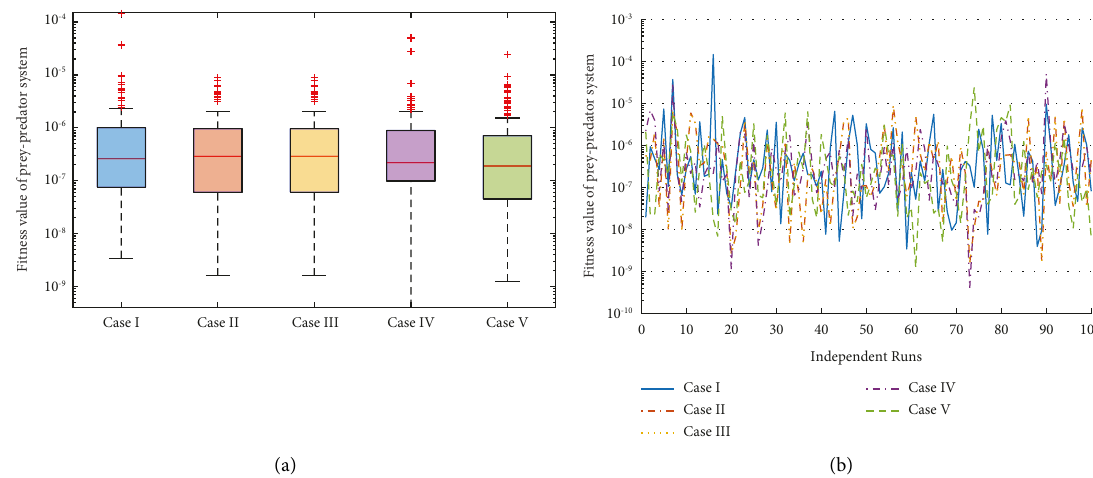
Figure 8: Comparison between the box plots and convergence graphs of fitness evaluation over 100 independent runs for the prey-predator model with variations in force of interaction between local and immigrant prey. (a) Box plots for fitness evaluation of the prey-predator model with variations in β . (b) Convergence of the fitness value of the prey-predator model with variations in β 1